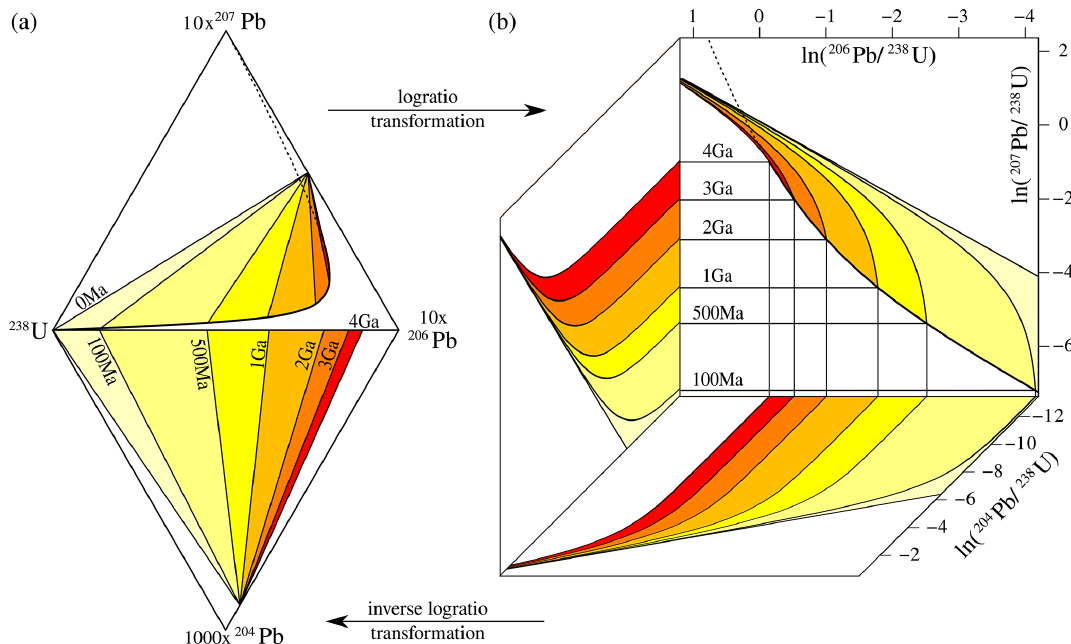
Figure 2. The U–Pb age equation (a) projected onto the four-component simplex and (b) mapped to a three-dimensional Euclidean log- ratio space. 235 U is omitted from the diagrams because it exists in a constant ratio to 238 U ( 238 U / 235 U = 137.818, Hiess et al., 2012). The boundaries between the coloured regions mark mixing lines between radiogenic and inherited end-member compositions, assuming common Pb ratios of [ 207 Pb / 204 Pb] c = 10 and [ 206 Pb / 204 Pb] c = 9. The mixing lines define isochron surfaces that are linear in the simplex and curved in log-ratio space. Rotating the log-ratio plot 90 ◦ clockwise produces a logarithmic version of the familiar Wetherill concordia diagram. Concordant 206 Pb / 238 U and 207 Pb / 235 U compositions are marked by a thick black line from 0 to 4Ga and by a dotted line beyond 4Ga. This paper makes the case that U–Pb data processing is best done in log-ratio space because this “liberates” the data from the geometric constraints of the simplex, producing symmetric uncertainty distributions and more accurate